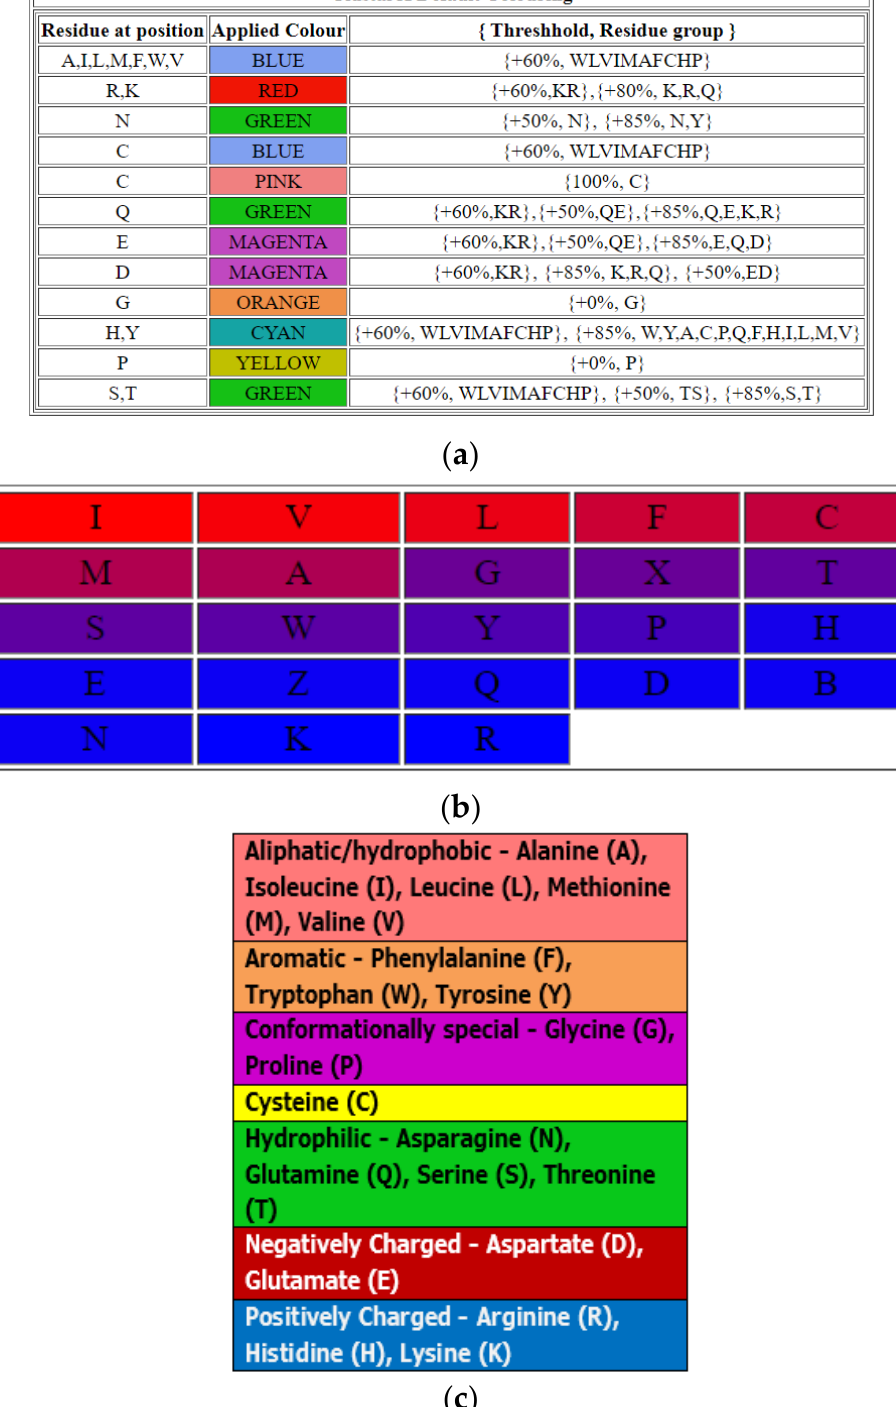
Figure A2. Different nAChRs found in muscle synapse: (a)mostly in vertebrate and ( b ) mostly in invertebrate. Source: adapted from [35].